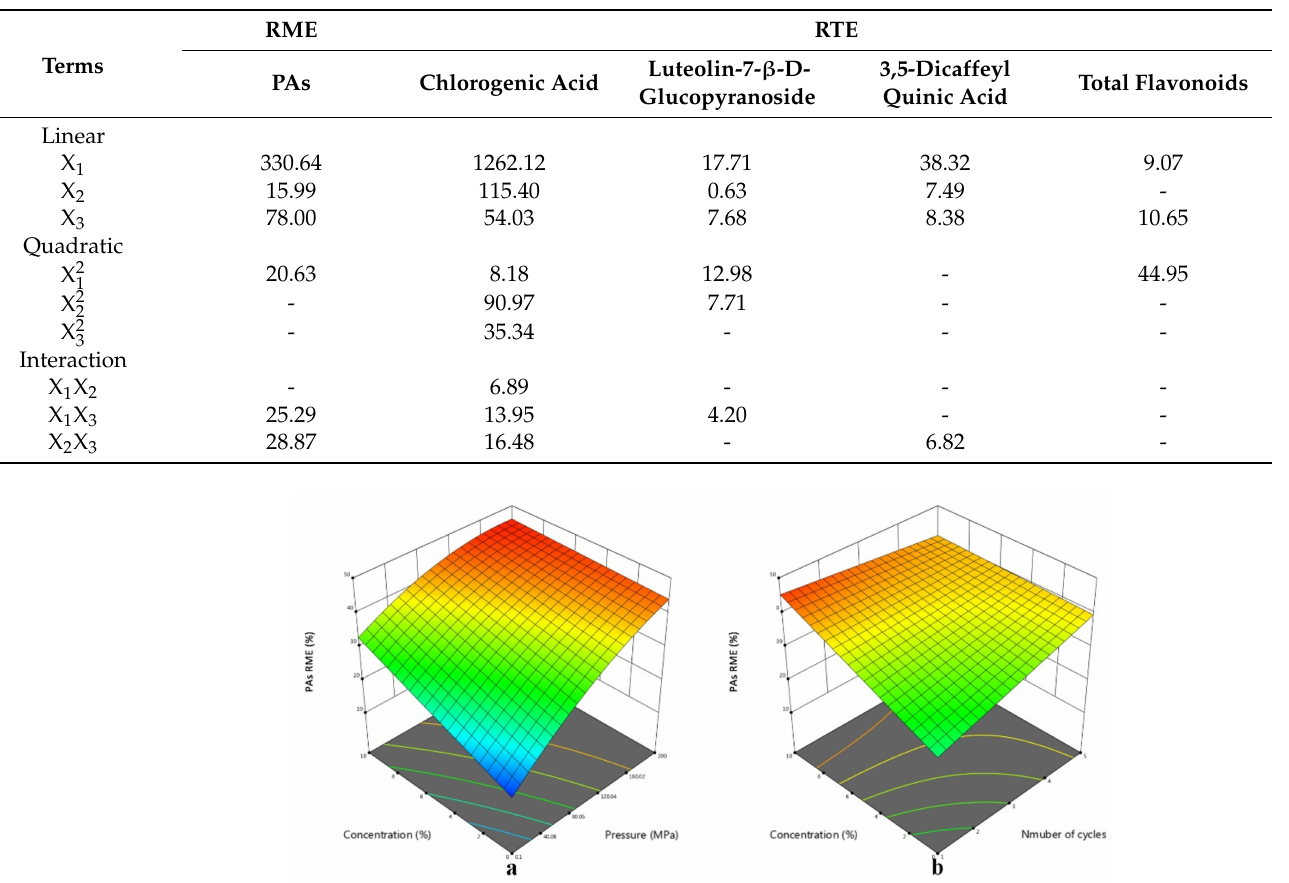
Table 3. F-ratio of terms in final models.